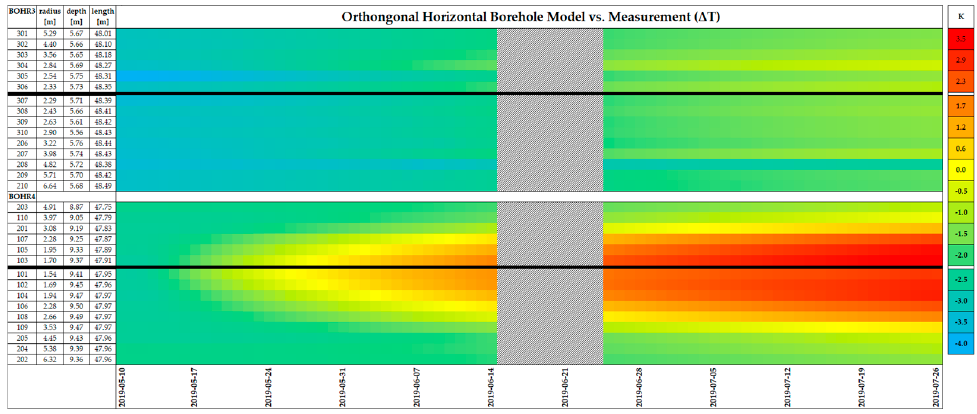
Figure 26. BOHR3 and BOHR4 modeled temperatures plotted against measured temperatures.